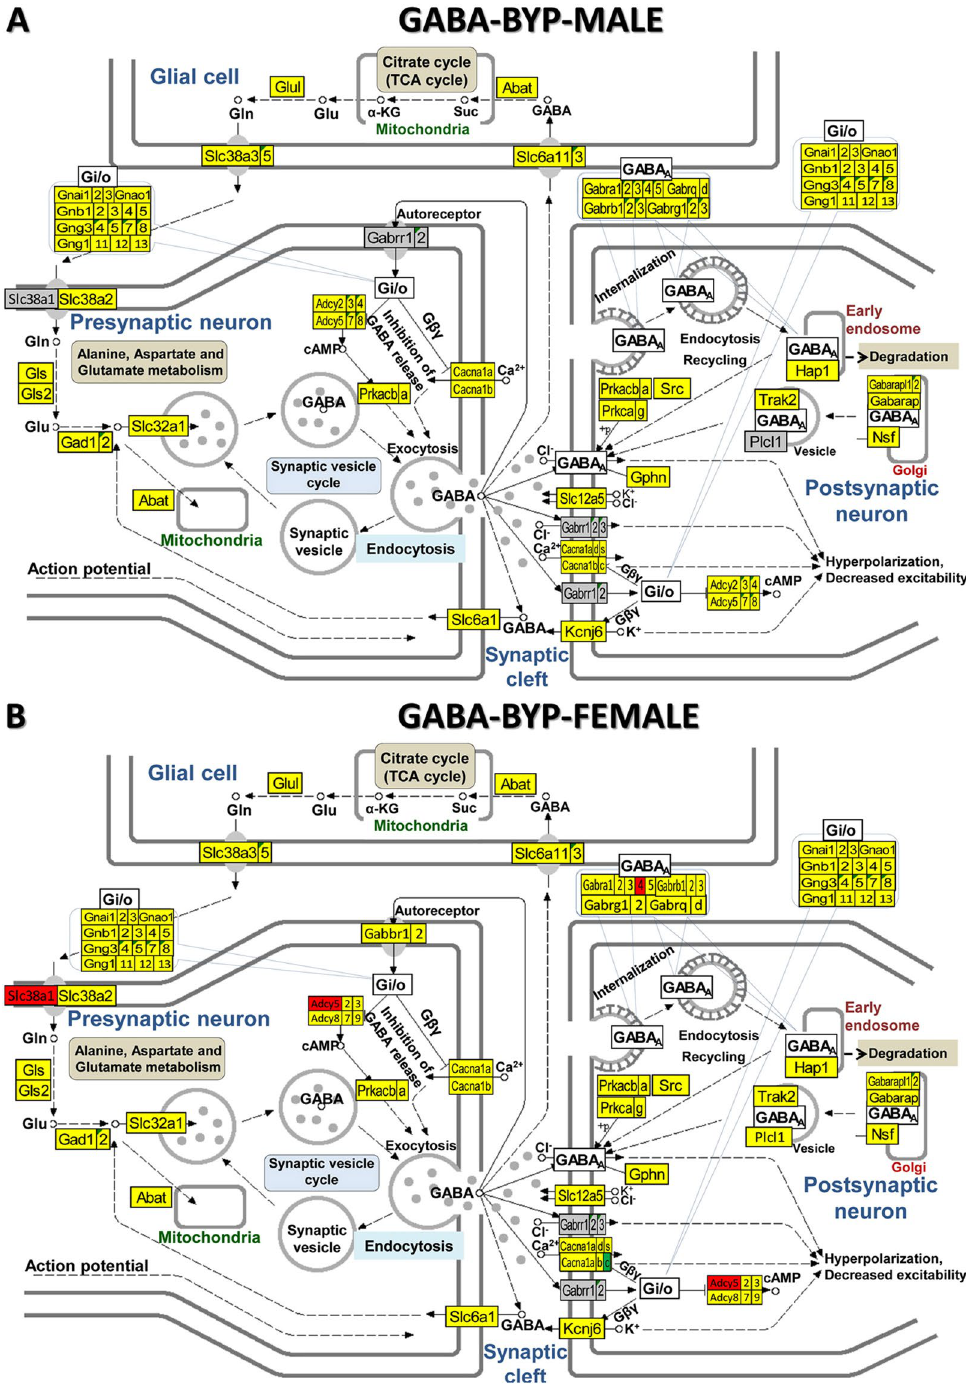
Figure 6. KEGG (www.kegg.jp/kegg/kegg1.html) map of regulation of the GABAergic synapse pathway in the arcuate nucleus of PMX53-treated betamethasone–primed male ( A ) and female ( B ) rats with NMDA-induced infantile spasms (BYA) compared to counterparts without spasms